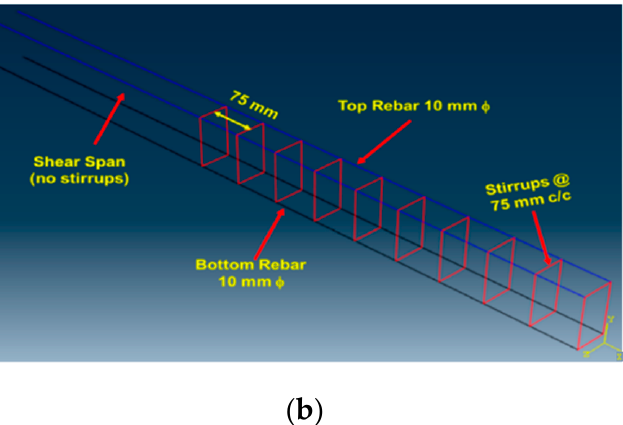
Figure 5. Representation of ECC and steel elements modelled in FE analysis: ( a ) concrete, ( b ) steel reinforcement.